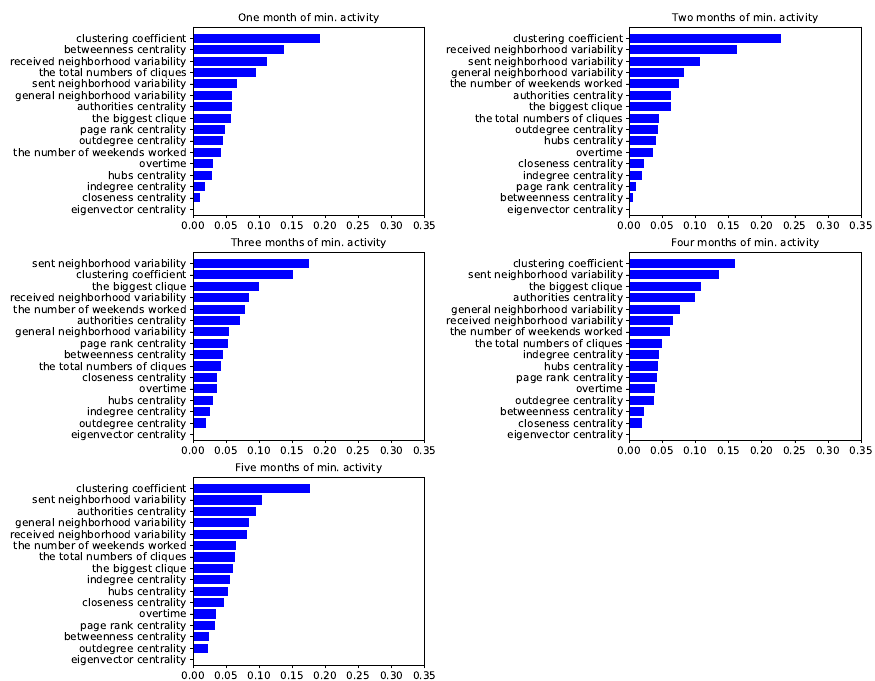
Figure A4. Features importance (Gini importance) for the Random Forest which uses the full set of features for the manufacturing company dataset with three levels of the